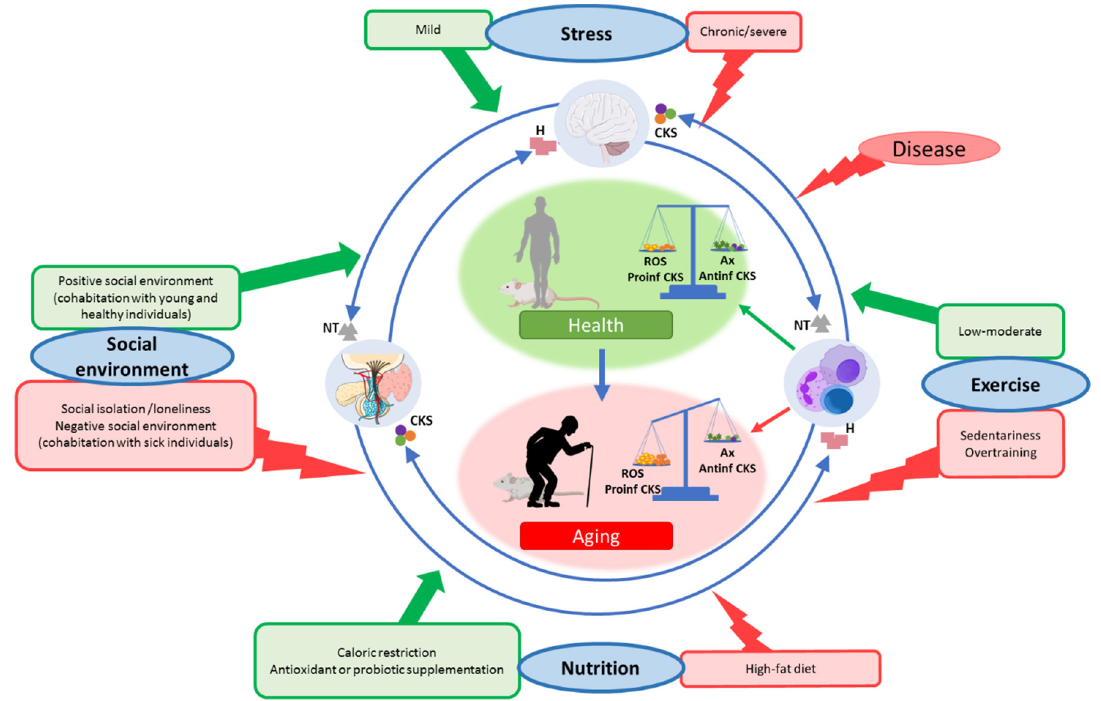
Figure 3. Dual effect of different lifestyle situations on oxi-inflamm-aging . The communication between the regulatory systems (nervous, endocrine, and immune systems), known as neuroimmunoendocrine communication, ensures the homeostasis of the organism and, therefore, health. This crosstalk takes place by the existence of receptors in each homeostatic system for neurotransmitters (NT), hormones (H), and cytokines (CKS). Oxi-inflamm-aging alters the function of the regulatory systems as well as the neuroimmunoendocrine communication, which causes age-related increased morbidity and mortality. External factors, such as the social environment, nutrition, and exercise, can modify the oxidative and inflammatory stress of the organism and the function of immune, nervous, and endocrine cells, altering this communication, and consequently, modulating the aging rate of an individual. Thus, a negative social environment, which can be the isolation of an individual (rodents) or loneliness (humans), or the cohabitation with sick or older subjects, affects the neuroimmunoendocrine communication negatively, increasing the rate of aging while a positive social environment, understood as living with healthy or younger individuals, enhances this communication, decreasing the aging rate. With respect to nutrition, high-fat diets and obesity, as well as an excess of antioxidant supplementation, accelerate the rate of aging, whereas caloric restriction or supplementation with adequate amounts of vitamins, antioxidants, or probiotics decelerate it. Finally, whereas a sedentary life or overtraining can negatively impact the aging rate, low and moderate exercise was shown to slow down aging. All these conditions modulate the function of immune cells by increasing or decreasing oxidant, pro-inflammatory, antioxidant, and anti-inflammatory compounds; therefore, they can alter the rate of oxi-inflamm-aging. Antinf CKS: anti-inflamatory cytokines; Ax: antioxidants; CKS: cytokines; H: hormones; NT: neurotransmitters; Proinf CKS: pro-inflammatory cytokines.